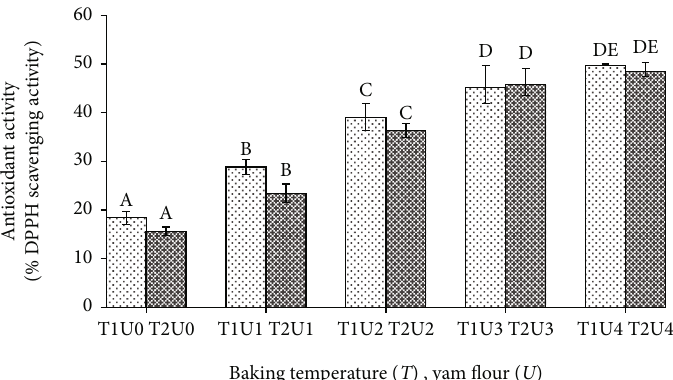
Figure 3: Antioxidant activity of plain bread with di ff erent baking temperature and yam fl our addition. Note: T1: baking temperature 170 ° C; T2: baking temperature 180 ° C; U0: yam fl our 0%; U1: yam fl our 10%; U2: yam fl our 15%; U3: yam fl our 20%; U4: yam fl our 30%. The letter above the bar graph beside the same number shows that it is not di ff erent based on the DNMRT statistical test at the level of con fi dence